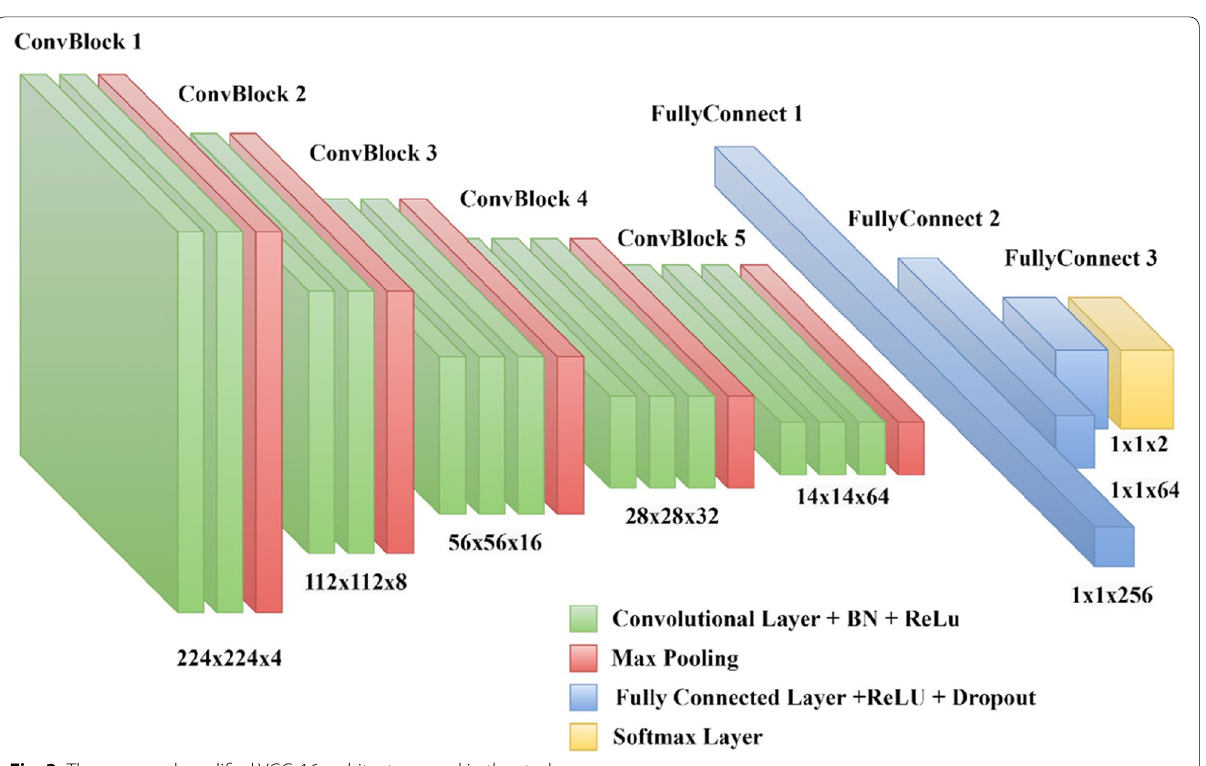
Fig. 3 The proposed modified VGG-16 architecture used in the